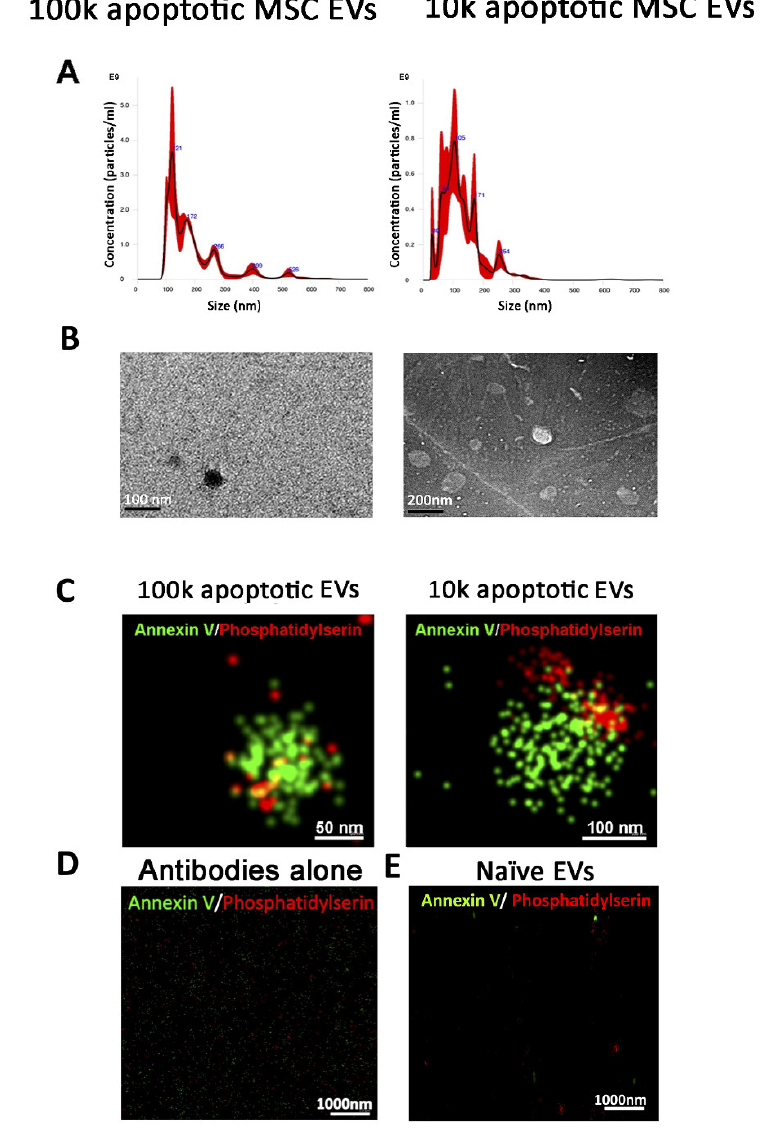
Figure 5. Characterisation of 100k and 10k apoptotic MSC EVs. ( A ) Representative graphs of nanoparticle tracking analysis of 100k apoptotic MSC EVs (left panel) and 10k apoptotic MSC EVs (right panel). ( B ) Representative images of transmission electron microscopy of 100k apoptotic MSC EVs (left panel) and 10k apoptotic MSC EVs (right panel). ( C ) Representative super-resolution microscopy images of 100k apoptotic MSC EVs (left panel) and 10k apoptotic MSC EVs (right panel) stained with Annexin V (green) and Phosphatidylserine (red). ( D ) Representative super-resolution microscopy image of Annexin V (green) and Phosphatidylserine (red) as a negative control without EVs. ( E ) Representative super-resolution microscopy image of 100k MSC EVs isolated from naive MSCs and stained with Annexin V (green) and Phosphatidylserine (red).